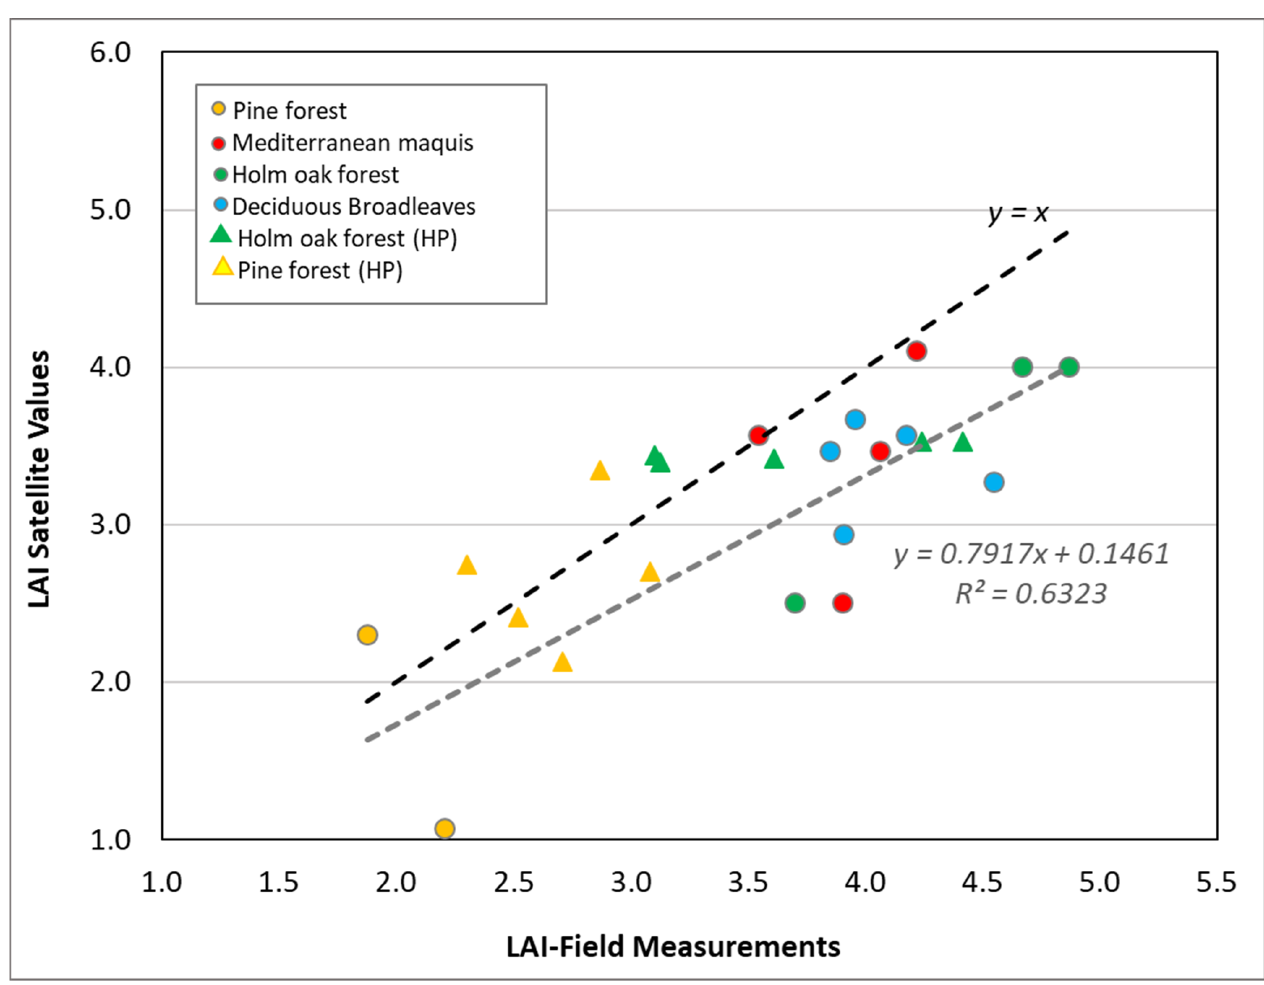
Figure 4. Correlation between ground-level measurement and satellite-level values of LAI (m 2 m − 2 ); different colors represent different LCT sampled inside the Estate. The circles indicate field measurements carried out with LAI-2200C Plant Canopy Analyzer; triangles indicate field measurements carried out with hemispherical photography (HP).